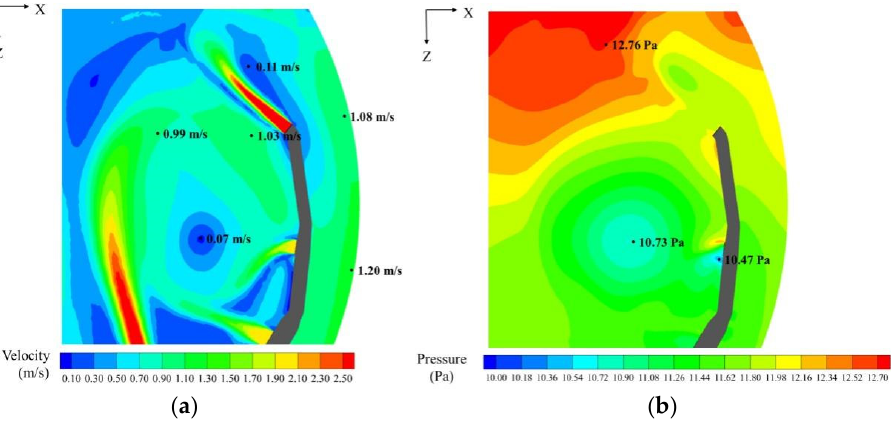
Figure 7. Velocity vector diagram at the section of y = 0.71 m under case A (dashed box represents the vortex area to be zoomed in Figure 8).